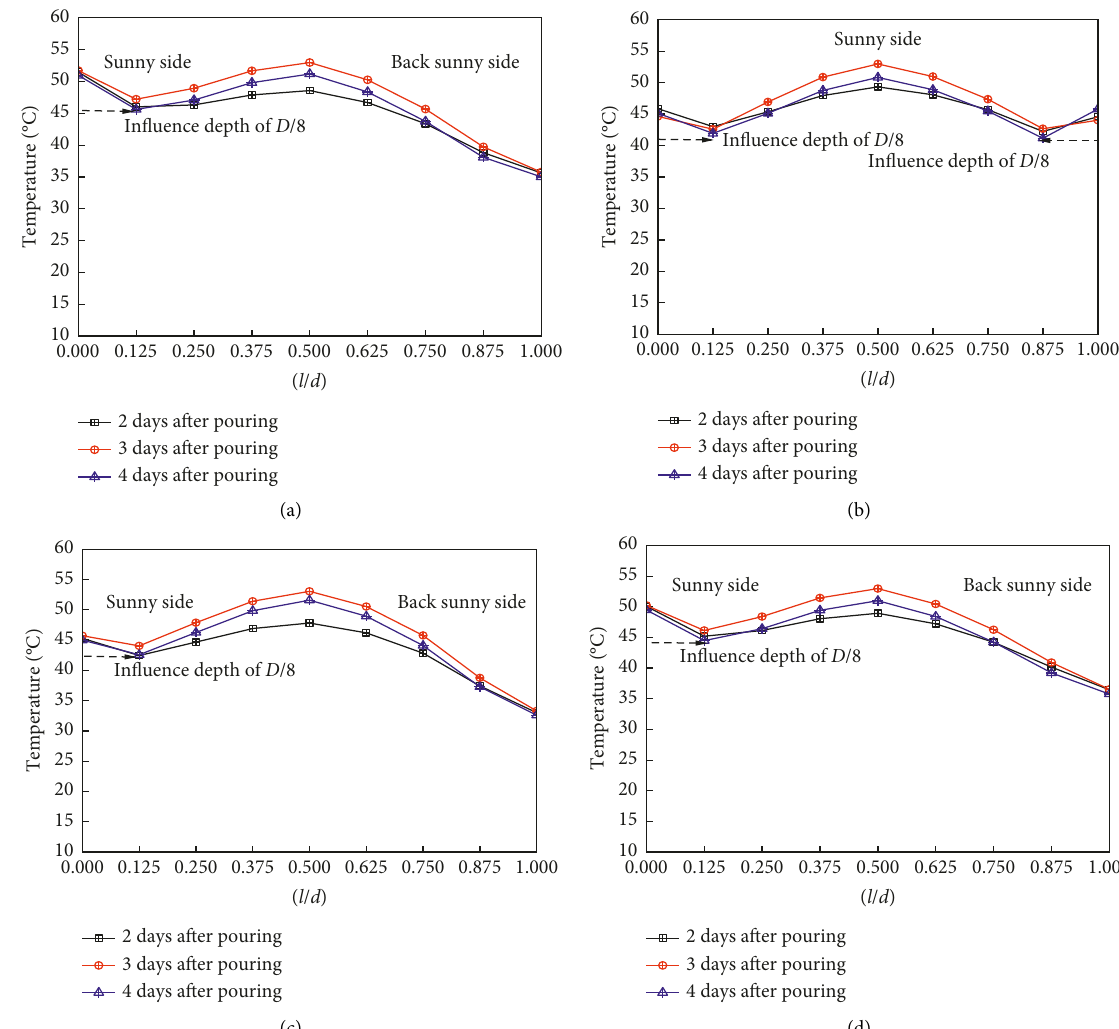
Figure 13: The distribution of the temperature field (2 pm): (a) A1-A2, (b) B1-B2, (c) C1-C2, and (d)